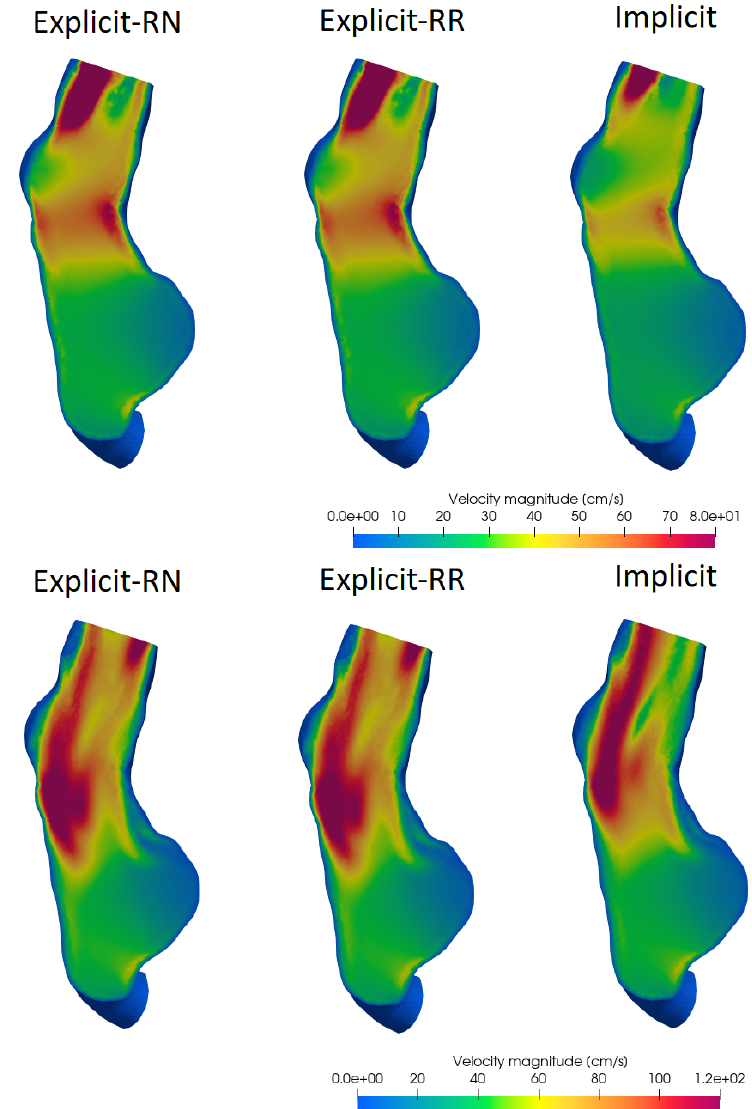
Figure 4. Velocity magnitude for the AAA simulation. Top: t = 0.05 s; Bottom: t = 0.1 s. Test